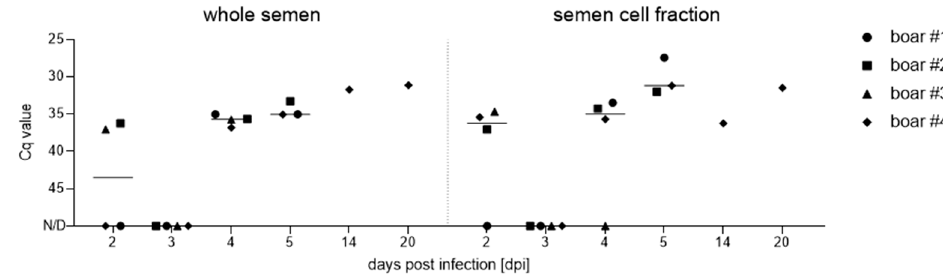
Figure 8. Assessment of ASFV genome loads in boar semen and corresponding cell fractions after infection with ASFV “Estonia14”. Results are depicted as Cq values and were evaluated by qPCR. Lines display the group median and each boar is represented by a unique symbol.